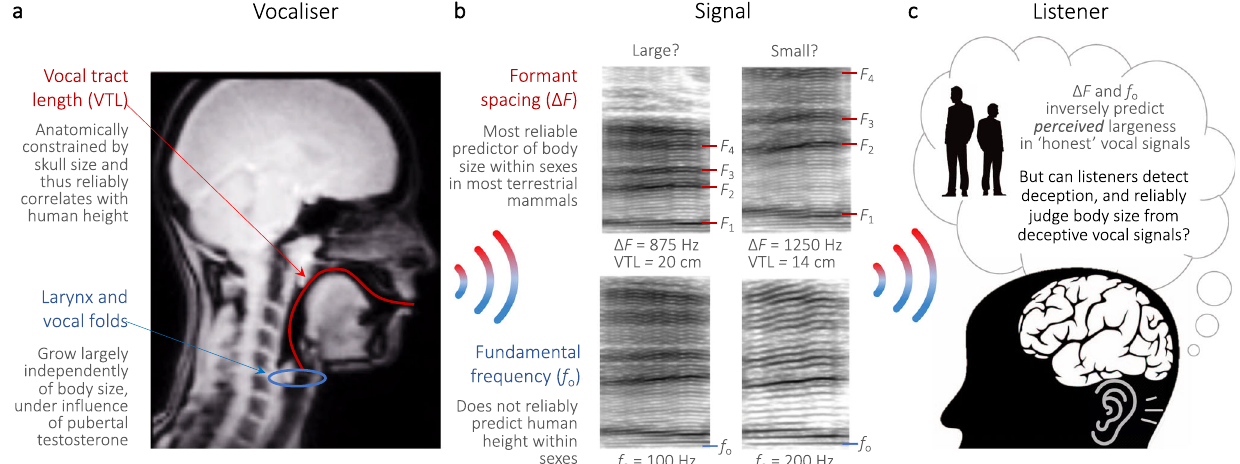
Fig. 1 Human vocal communication of body size. a Sagittal MRI image of human vocal anatomy illustrating vocal tract length (VTL) (in red) during production of the vowel /u:/, and permanently descended larynx housing the vocal folds (blue circle). Human VTL scales fairly allometrically with body size due to anatomical constraints, whereas vocal fold length does not 26,28,32,33 . b Resonances of the vocal tract termed formants (labelled F 1 – F 4 ) and their relative spacing ( Δ F ) inversely predict human height controlling for sex and age 33,34 , whereas fundamental frequency (labelled f o ), related to vocal fold length, does not 34 . c Human listeners robustly associate both voice frequencies (low Δ F and f o ) with large body size in regular speech 25,36 and in nonverbal vocalisations (e.g., roars 39 ), but can humans judge size from deceptive vocal signals? Panels a, b were reproduced and reformatted with permission 21 ; parts of panel c were designed using resources from freepik.com and rawpixel.com (https://www.freepik.com/free-vector/illustration-business- people_2609966.htm#query = man%20black%20silhouette&position =